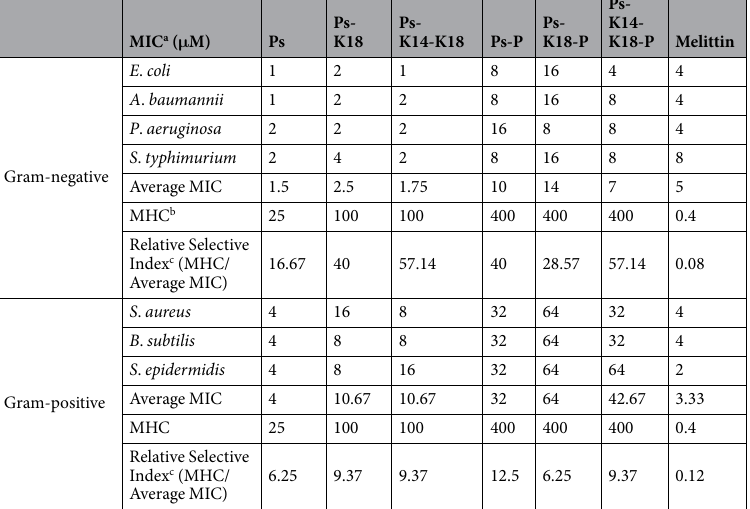
Table 2. Antimicrobial activities of the peptides against standard bacterial strains. a Minimum inhibitory concentrations (MICs) were determined in three independent experiments performed in triplicate with a standard deviation of 14.0%. b The minimal peptide concentration that produces haemolysis. c Ratio of the minimum haemolytic concentration (MHC; μ M) over the average of the MIC ( μ M). Larger values indicate greater cell selectivity.